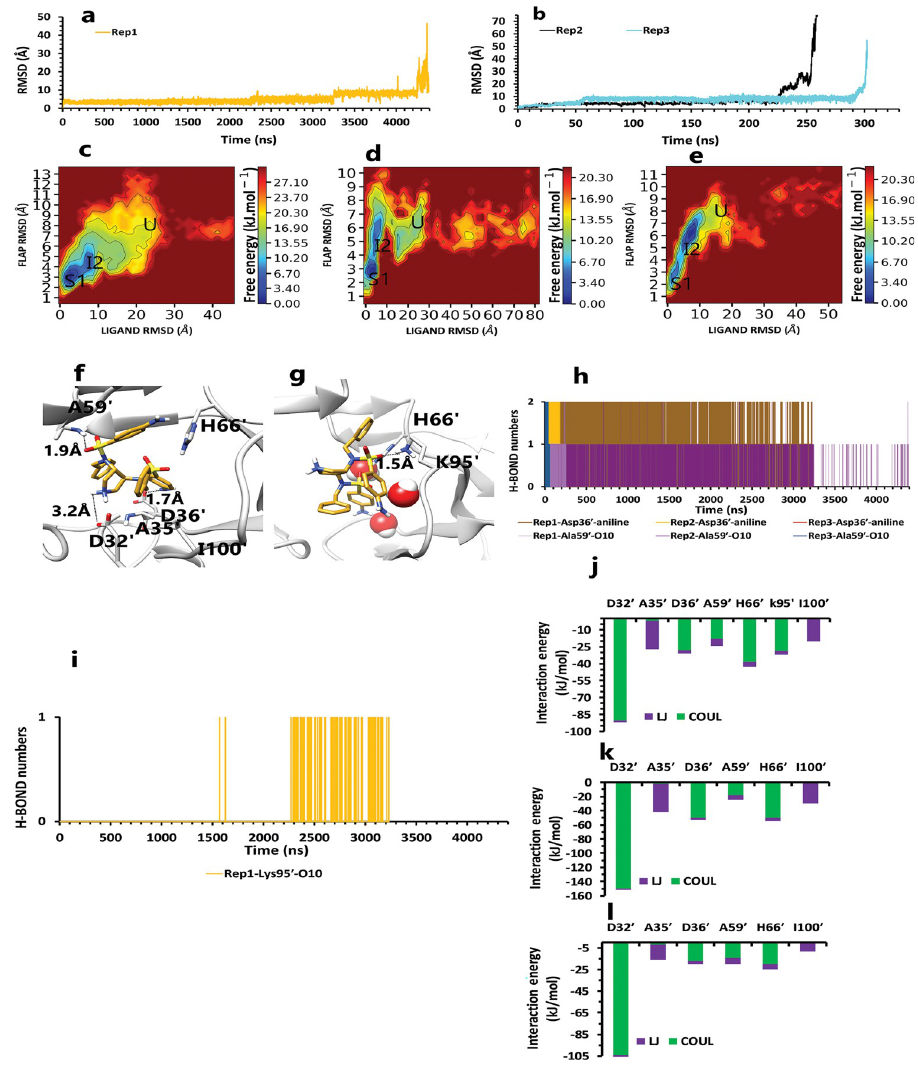
Fig 4. The details of compound 10 unbinding pathways in complex with HTLV-1 protease when Asp32 of chain A was protonated in three replicas. A , RMSD value of the ligand from binding pose to complete unbinding in the rep1. B , RMSD values of the ligand from binding pose to complete unbinding in the rep2 and rep3. C , D , and E , The free energy landscape of rep1, 2, and 3 during the unbinding process (state (S), intermediate state (I), unbound (U)), respectively, which was calculated by using "gmx sham". F , The interactions between the ligand and essential residues in the binding pose of rep1, 2, and 3. G , The new interactions between the inhibitor and particular residues in the second intermediate state of rep1. H , Hydrogen bond numbers of Asp36 0 and Ala59 0 with the inhibitor in rep1, 2, and 3. I , Hydrogen bond numbers of Lys95 0 with the inhibitor in rep1. J , K , and L , The average of most important interaction energies of the protein-ligand complex in rep1, 2, and 3,